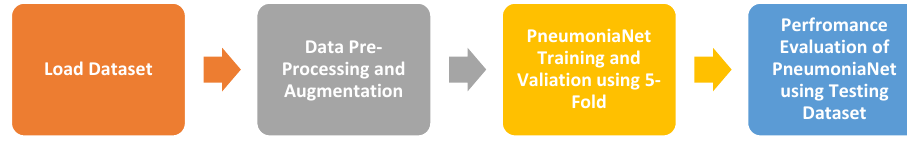
Figure 2. Flow diagram of the proposed methodology.